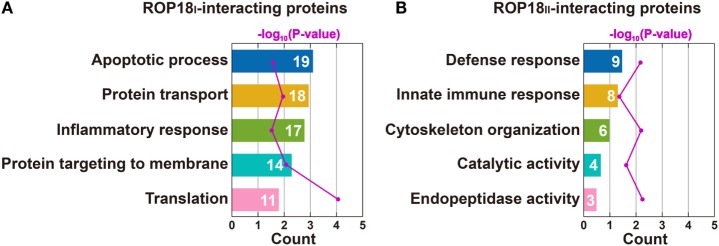
Top five enriched biological processes for ROP18I
(A) and ROP18II-interacting proteins (B) identified by GO analysis. (A) ROP18I-interacting proteins were significantly overrepresented in the biological processes of apoptotic process, protein transport, inflammatory response, protein targeting to membrane, and translation. (B) ROP18II-interacting proteins were significantly overrepresented in the biological processes of defense response, innate immune response, cytoskeleton organization, catalytic activity, and endopeptidase activity.